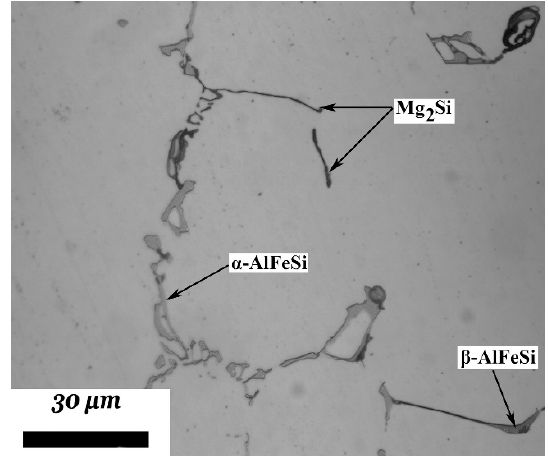
Figure 3. As-cast microstructure of alloy 6082. Reprinted with permission from International Journal of Materials Research, Vol. 105 (2014) pp. 1202–1209 by P.I. Sarafoglou and G.N. Haidemenopoulos, (c) Carl Hanser Verlag GmbH and Co.KG, Muenchen. (c) Carl Hanser Verlag GmbH and Co.KG, Muenchen. Table 3. Fractions of phases and matrix composition close to the boundary in as-cast